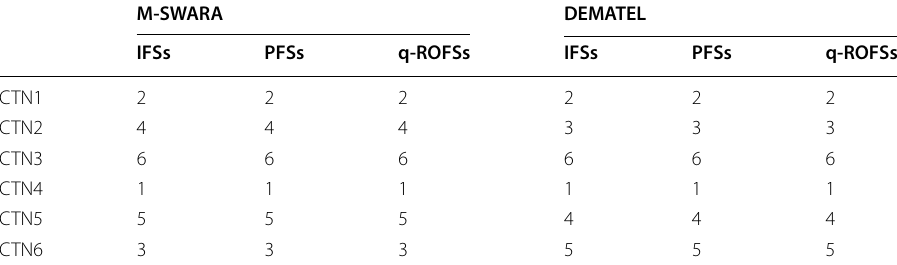
Table 9 Comparative weighting priorities for the